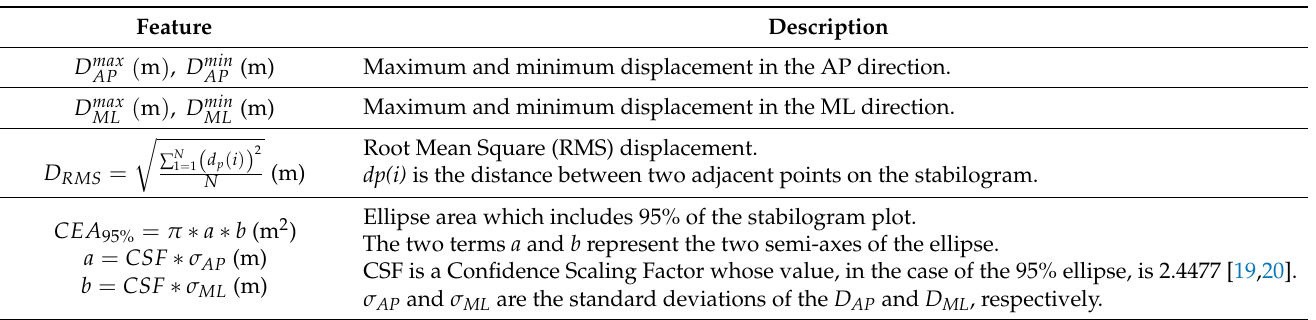
Table 2. Main features adopted through this work to implement algorithms for the analysis of postural